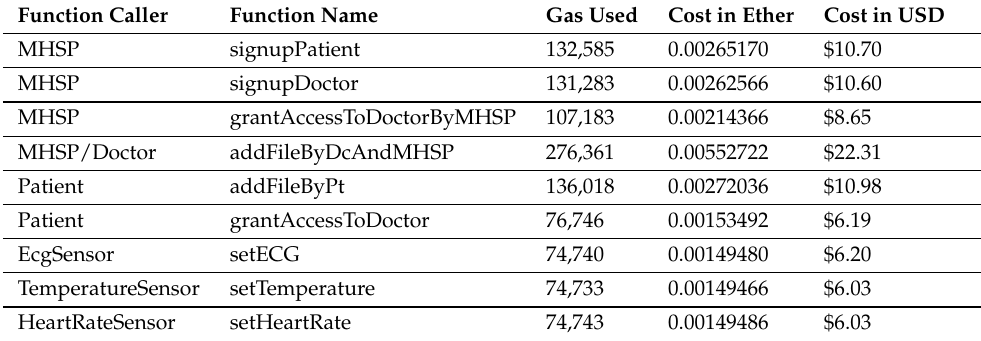
Table 4. Gas Costs of the Smart Contract’s Functions.